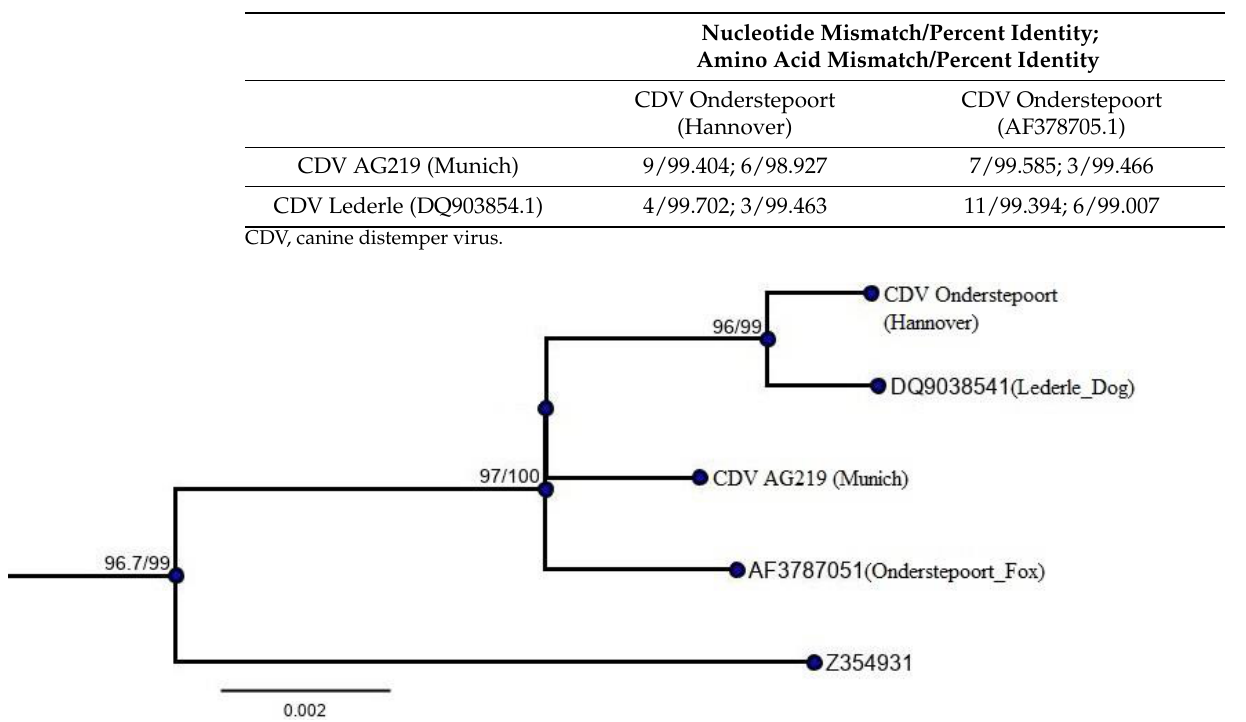
Table 2. Nucleotide and amino acid identity features of the test isolates for H genes and proteins against modified live vaccine strains of Onderstepoort and Lederle.